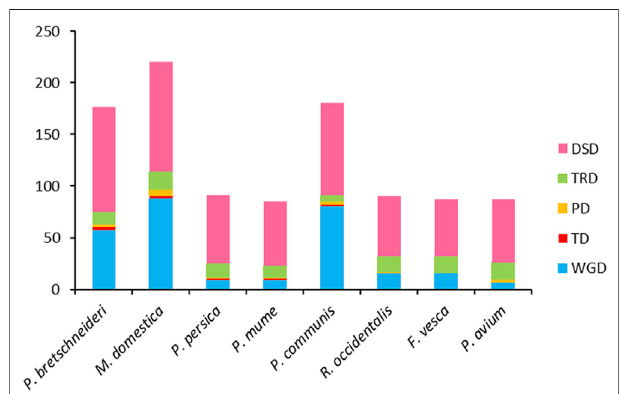
FIGURE2| Numberof PP2C genepairsderivedfromdifferentmodesof geneduplicationinpearandsevenotherRosaceaespecies. X -axisrepresents the species. Y -axis represents the number of duplicated gene pairs. WGD: whole-genome duplication, TD: tandem duplication, PD: proximal duplication, TRD: transposed duplication, and DSD: dispersed